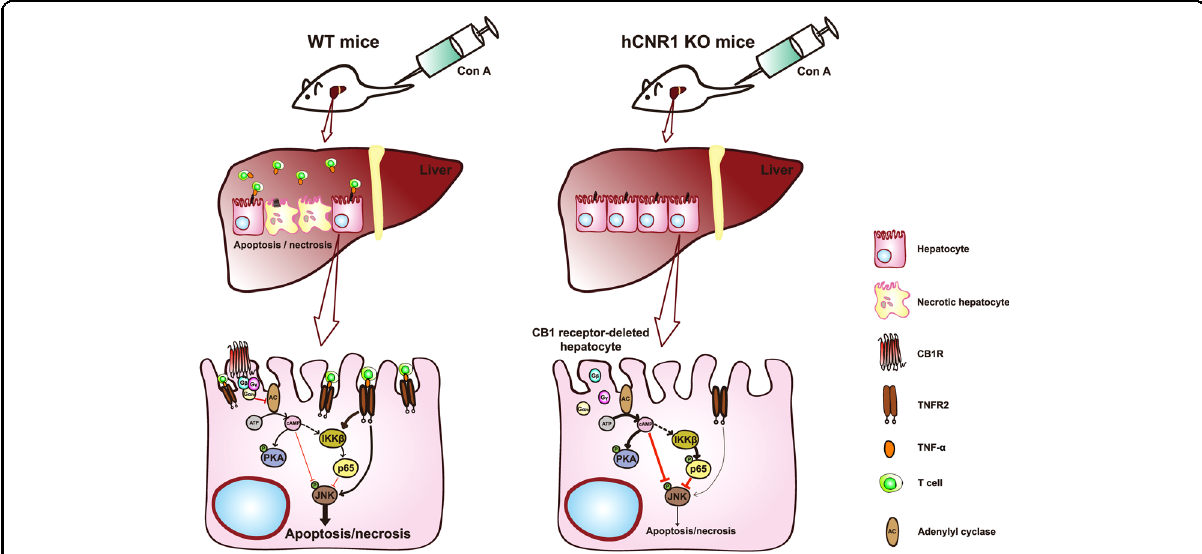
Fig. 7 Schema of the suggested protective mechanism of hepatic cannabinoid 1 (CB1) receptor nulli fi cation/blockade on liver injury by Con A treatment. Nulli fi cation of hepatocyte-speci fi c CB1 receptor reduces in fi ltration of T cells containing membrane-bound TNF- α in liver and reduces TNFR2 levels in isolated hepatocytes. Interaction between membrane-bound TNF- α and TNFR2 results in the activation of JNK and apoptotic cell death in WT mice. hCNR1 − / − mice also have increased cAMP levels and PKA activation, and consequently decreased phosphorylation of JNK. Additionally, CB1 receptor-deleted hepatocytes have higher expression of phosphorylated NF- κ B subunit, p65 (S536), via activation of IKK β resulting in the protection of hepatocytes against apoptotic cell